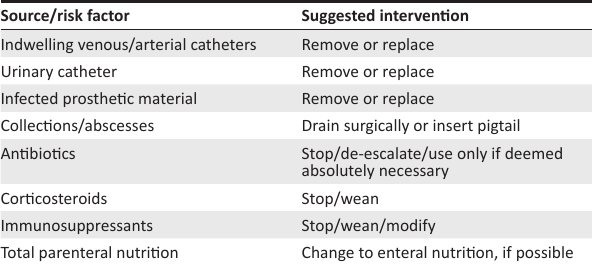
TABLE 8: Source control and risk factor modification